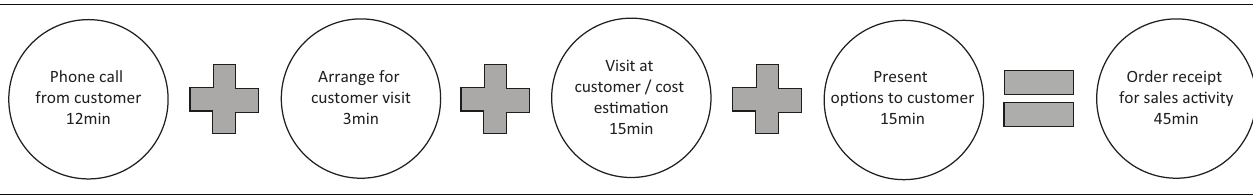
FIGURE 2: Allocation of work steps to sub-activity.